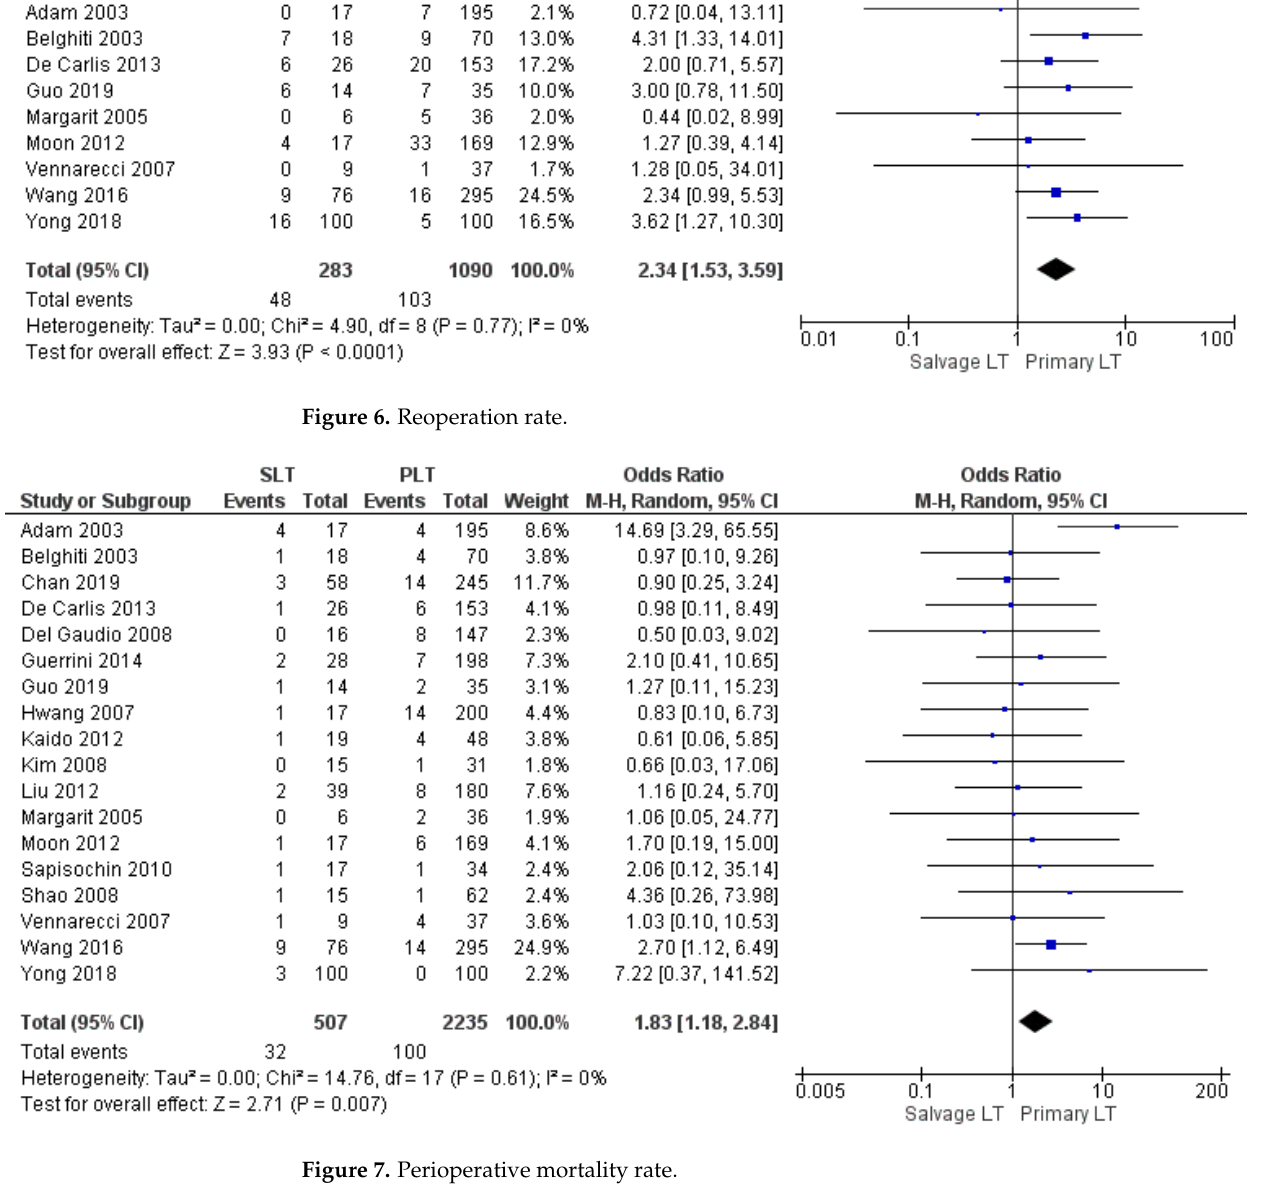
Figure 6. Reoperation rate.